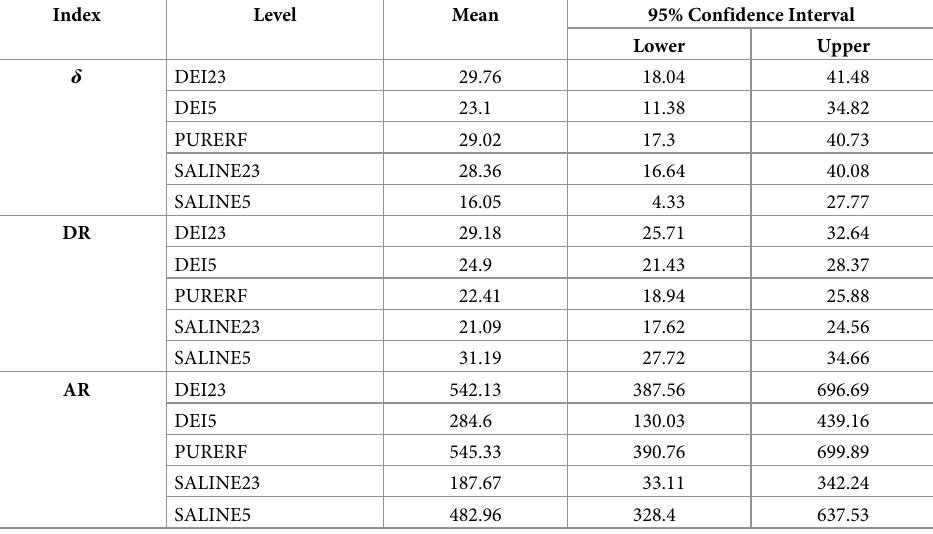
Table 2. Estimated marginal averages of performance indices for groups DEI23, DEI5, PURERF, SALINE23 and